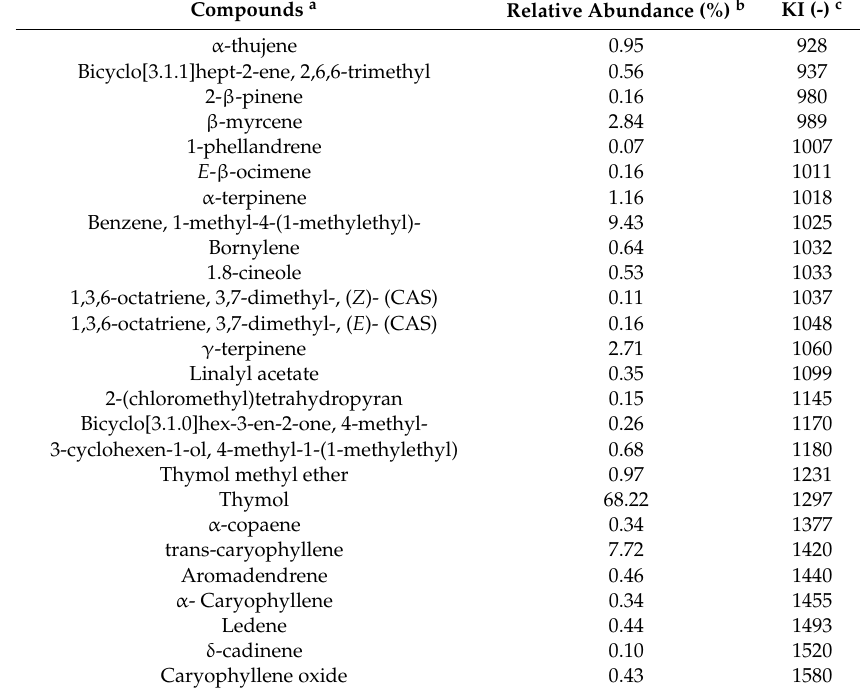
Table 2. Constitution of Lippia sidoides essential oil (EO) identified by gas chromatography coupled to mass spectrometry